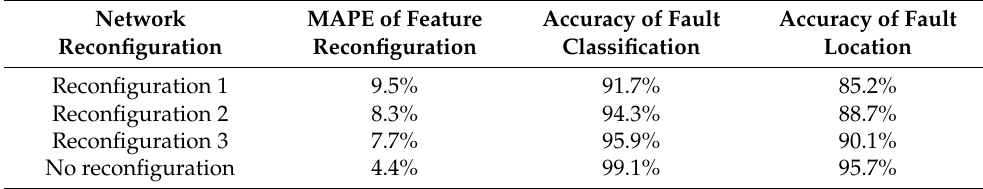
Figure 12. Fault location results of different reconfigurations of the distribution network. Table 5. Comparison results of different reconfiguration of distribution network.